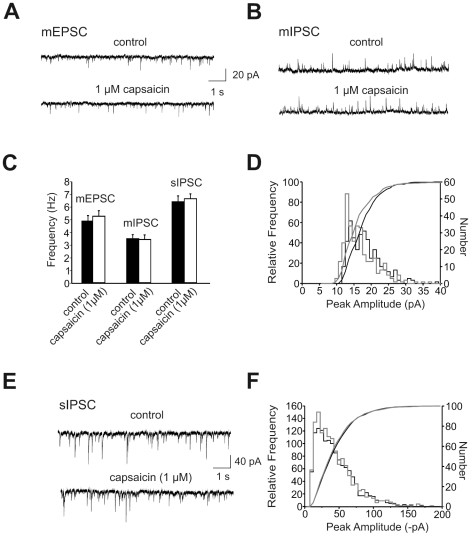
Properties of spontaneous PSCs in the absence and presence of TTX.(A) Continuous recording shows spontaneous EPSCs in the presence of TTX (mEPSCs) from a LA projection neuron under control conditions and 10 min after bath application of capsaicin (1 µM), Vm = −70 mV. (B) Continuous recording shows spontaneous IPSCs in the presence of TTX (mIPSCs) from another LA projection neuron under control conditions and 10 min after bath application of capsaicin (1 µM), Vm = 0 mV. (C) Summary data shows mean frequency of mEPSCs, mIPSCs and sIPSCs under control conditions and in the presence of capsaicin, SEM is indicated by error bars. (D) Amplitude distributions of mIPSCs recorded in under control conditions (black) and in the presence of 1 µM capsaicin (grey). Superimposed lines show cumulative amplitude histograms (p>0.05, Kolmogoroff-Smirnov test). (E) Continuous recording shows spontaneous IPSCs in the absence of TTX (sIPSCs) under control conditions and 10 min after bath application of capsaicin (1 µM), Vm = −70 mV. (F) Amplitude distributions of sIPSCs recorded in under control conditions (black) and in the presence of 1 µM capsaicin (grey). Superimposed lines show cumulative amplitude histograms.